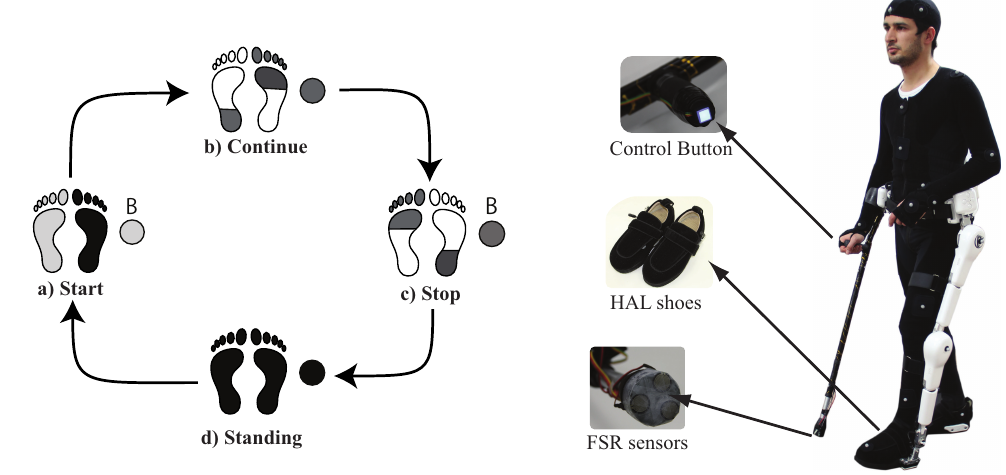
Figure 2. Start, walk and stop support based on ground contact